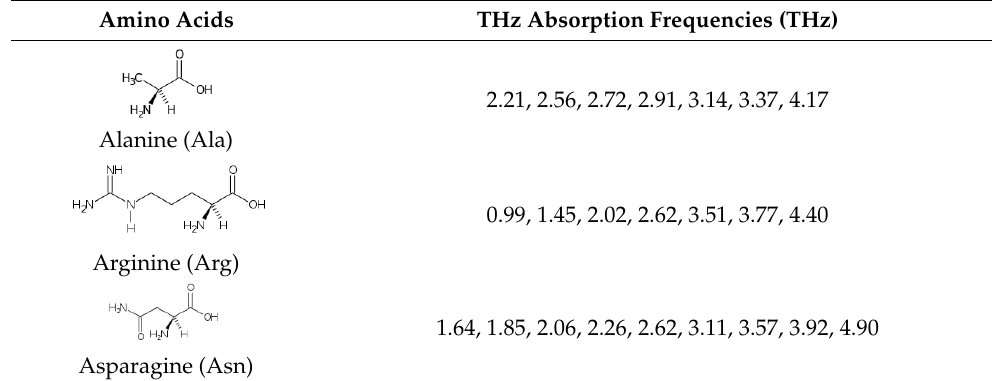
Table 1. Main THz absorption frequencies observed in the literature [118–134]. Amino Acids THz Absorption Frequencies (THz) Amino